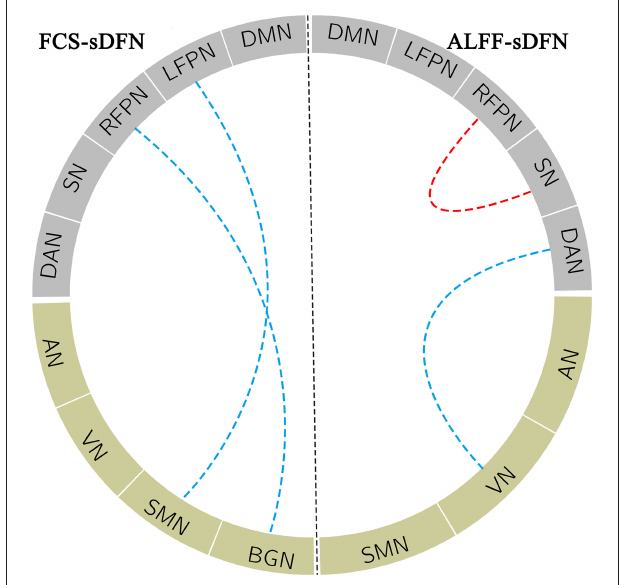
FIGURE 4 | The blue dotted line within the FCS_sDFN section denotes decreased negative connectivity between sDFNs in schizophrenic patients compared to healthy controls. Within ALFF_sDFN, the red dotted line denotes reduced positive connectivity; the blue dotted line represents the decreased negative connectivity between sDFN in schizophrenic subjects compared to healthy controls. FCS, functional connectivity strength; ALFF, amplitude of low-frequency fluctuations; sDFN, spatial organization of dynamic functional network; DMN, default model network; LFPN, left frontoparietal network; RFPN, right frontoparietal network; SN, salience network; DAN, dorsal attention network; AN, auditory network; VN, visual network; SMN, sensorimotor network; BGN, basal ganglia